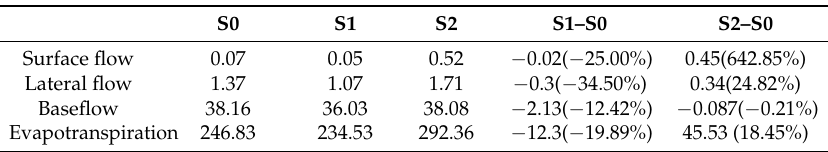
Table 7. Changes in annual mean hydrological components under different climate variability scenarios (mm/year). S0 S1